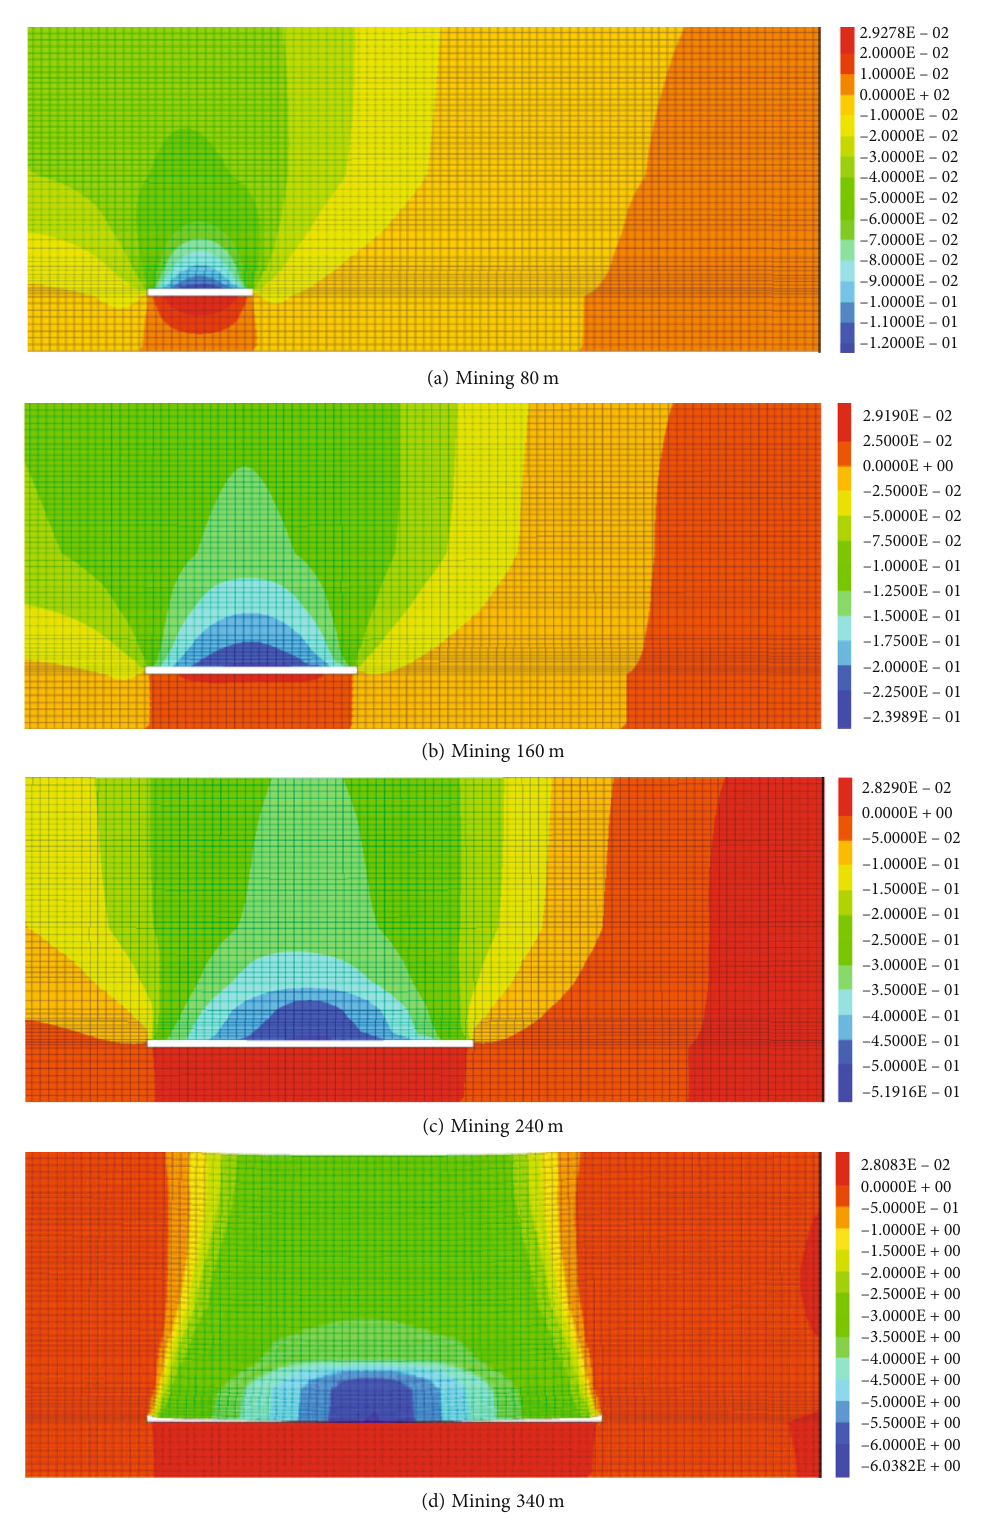
Figure 10: The vertical displacement nephograms during